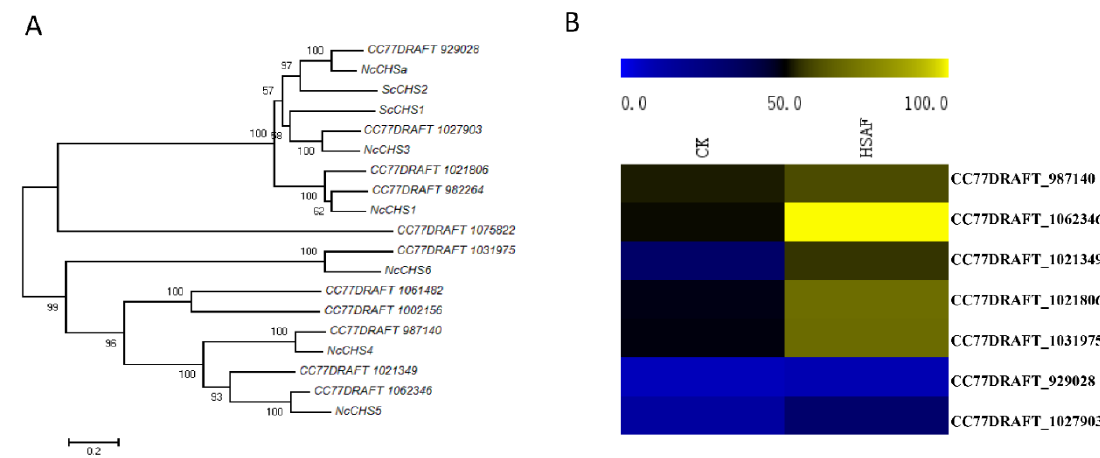
Figure 7. The chitin synthases characterization and their expression levels. ( A ) Phylogenetic analysis of fungal CHSs. Protein sequences of ScCHS1 (SCRT_02929) and ScCHS2 (SCRT_03322) were downloaded from Saccharomyces cerevisiae genome database. Protein sequences of NcCHSa (EAA32767.3), NcCHS1 (EAA32102.2), NcCHS3 (EAA32006.2), NcCHS4 (ESA44002.1), NcCHS5 (EAA27097.2), and NcCHS6 (EAA32522.3) were downloaded from the NCBI database. The